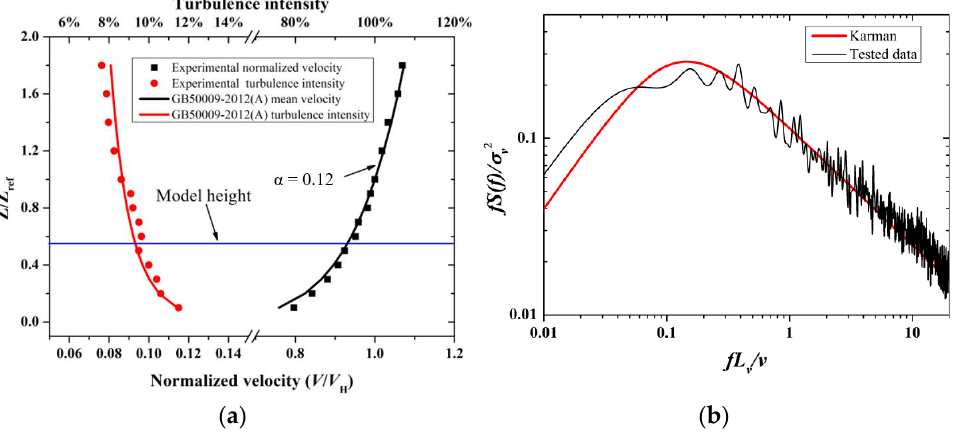
Figure 4. Simulated wind parameters in the wind tunnel tests: ( a ) mean speed and turbulence intensity; and ( b ) longitudinal turbulence spectrum at the reference height.